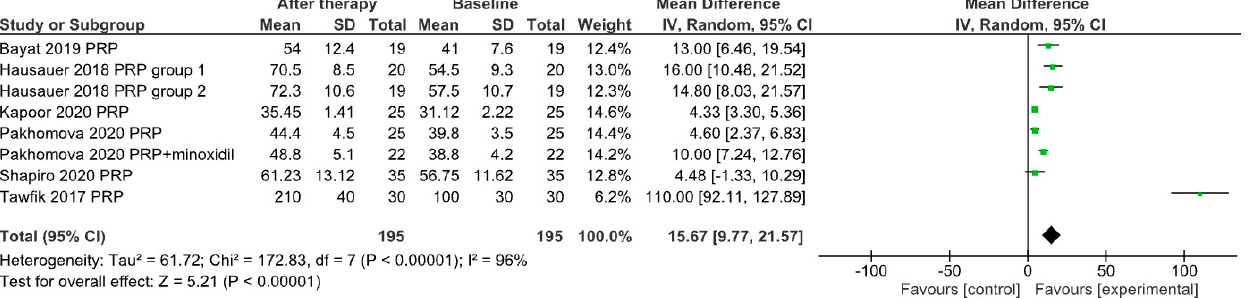
Figure 7. Forrest plot showing the effects of PRP treatment on mean hair diameter in selected study groups.